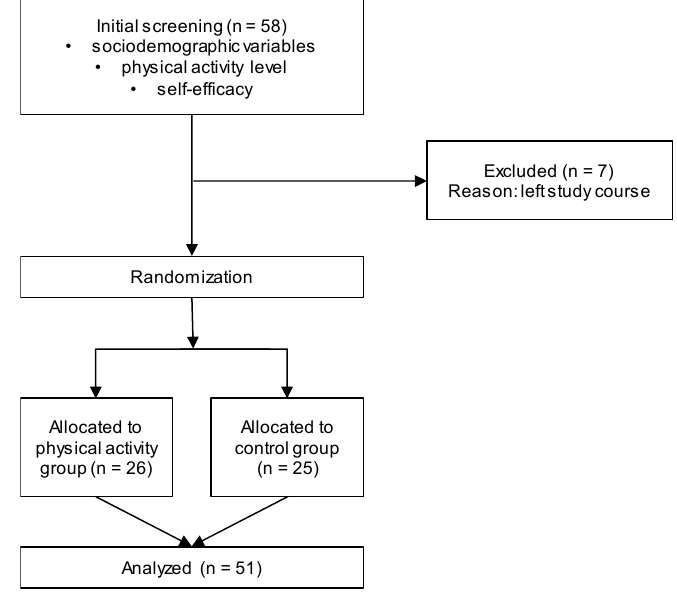
Figure 1. Flow diagram for data collection.